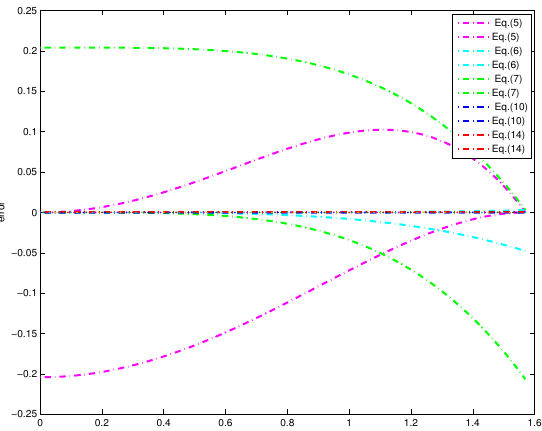
Figure 5. Error plots between sinc(x) and the polynomial bounds of degrees 4 and 5.